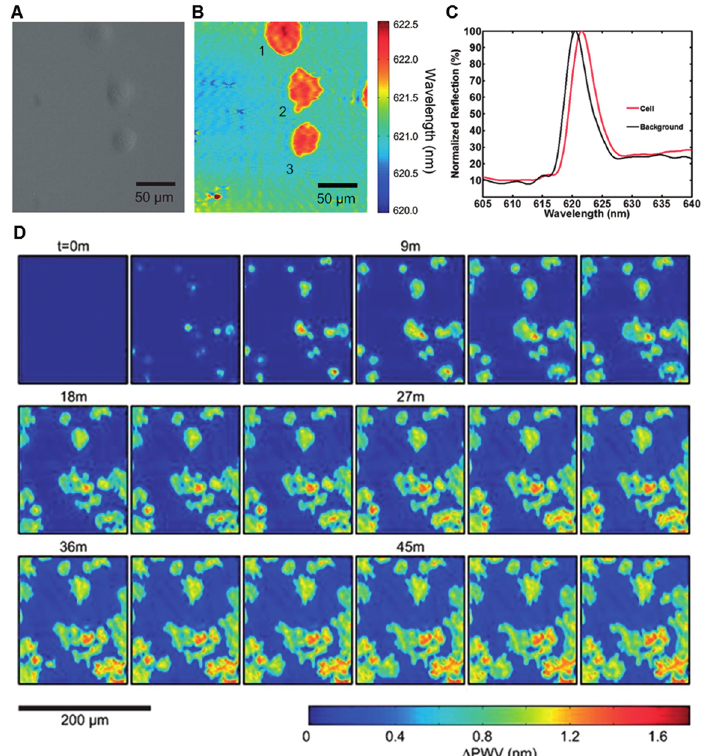
Figure 5. Wavelength-sensitive live cell image from instrument 3–PCEM. ( A ) Brightfield and ( B ) PWV images of Panc-1 cells attached to the PC surface. Lamellipodial extensions are visible, especially from cell 2, demonstrating the ability of PCEM to resolve regional differences in single-cell attachment; ( C ) Representative spectra (normalized) from background regions and regions with cellular attachment. Selected areas of the PWV image from beneath a cell show the PWS of a typical Panc-1 cell is ~1.0 nm; ( D ) Time-lapse PWS images of cellular attachment of dental stem cells (mHAT9a) (Reprinted in part with permission from [45], © 2013 RSC